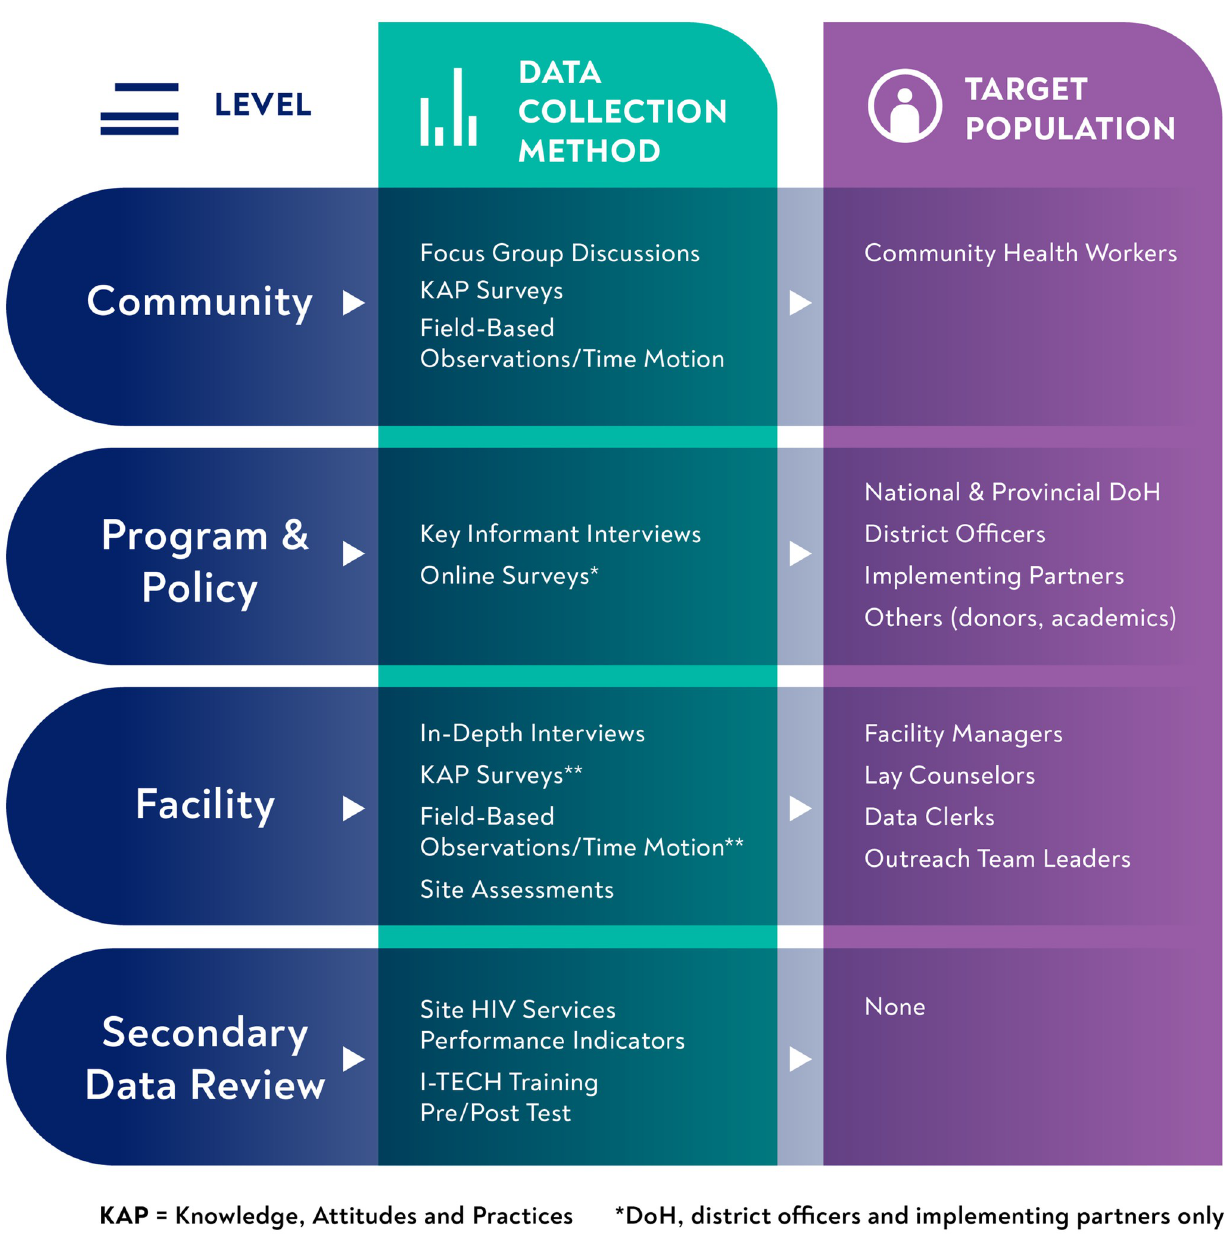
Fig 1. Multi-level, multi-method concurrent data collection. KAP, Knowledge, Attitudes and Practices; DoH, Department of Health � DoH, district officers and implementing partners only �� Outreach Team Leaders only.